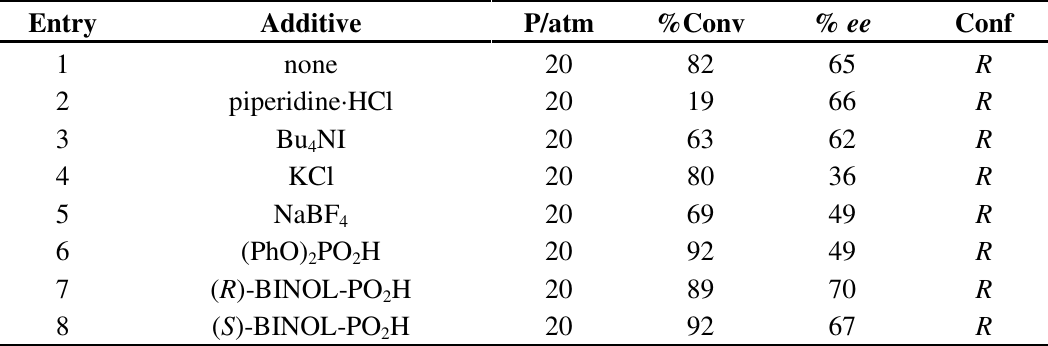
Table 4. Influence of diverse additives in the hydrogenation of 2-methylquinoline with ligand ( S )- 6b .